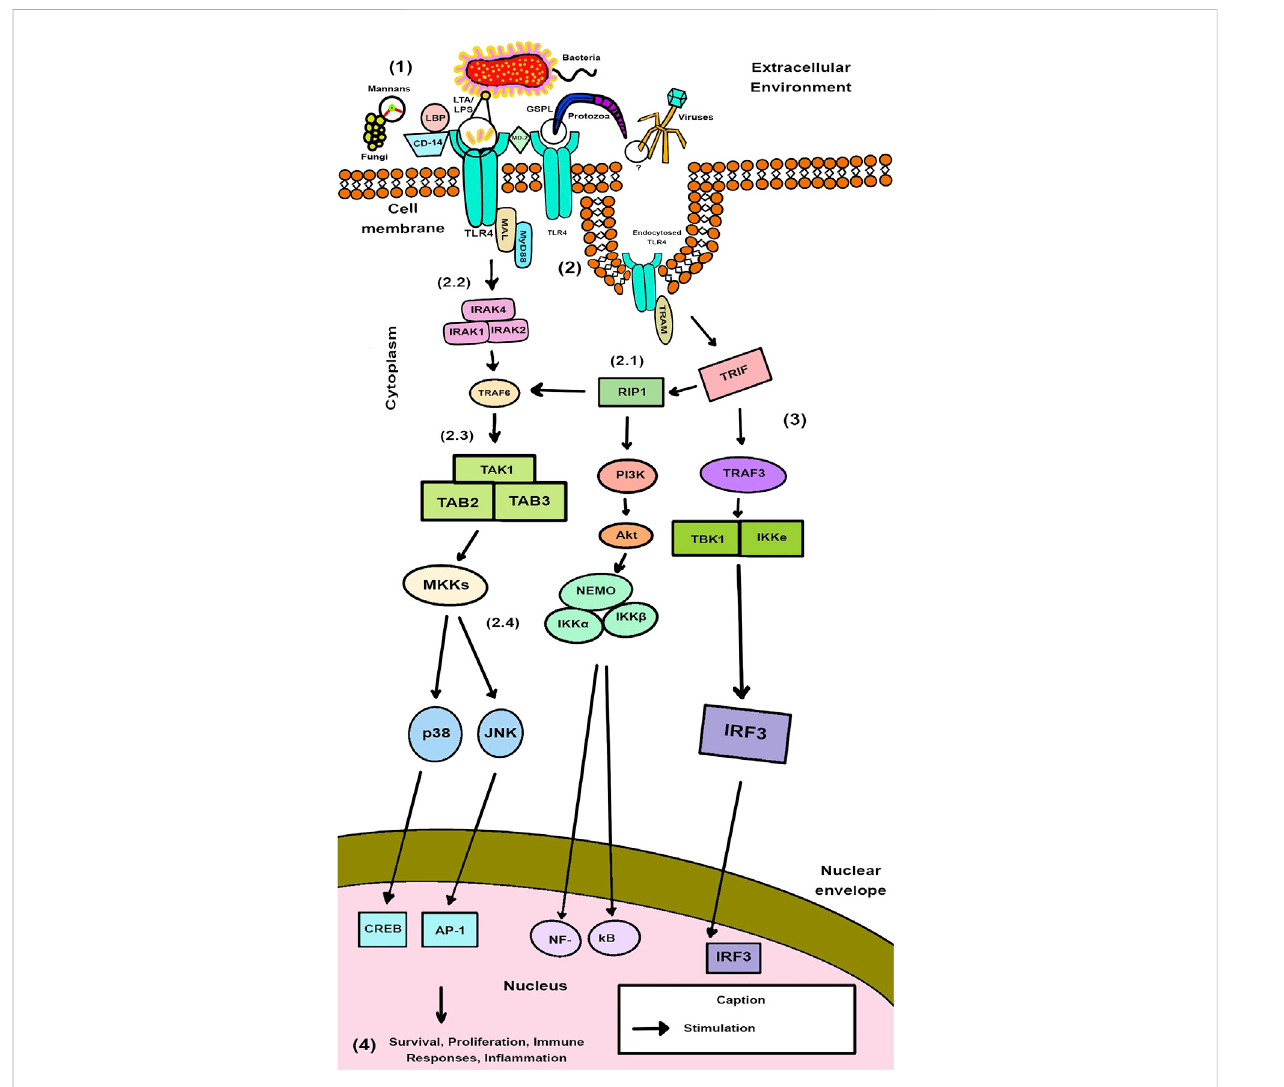
FIGURE 5 Schematic Model of TLR4 Signaling Transduction Pathways in Pathogen Recognition. Black circles from the top section of the fi gure indicate the PAMPs that are recognized by TLR4 for each type of infectious agent.